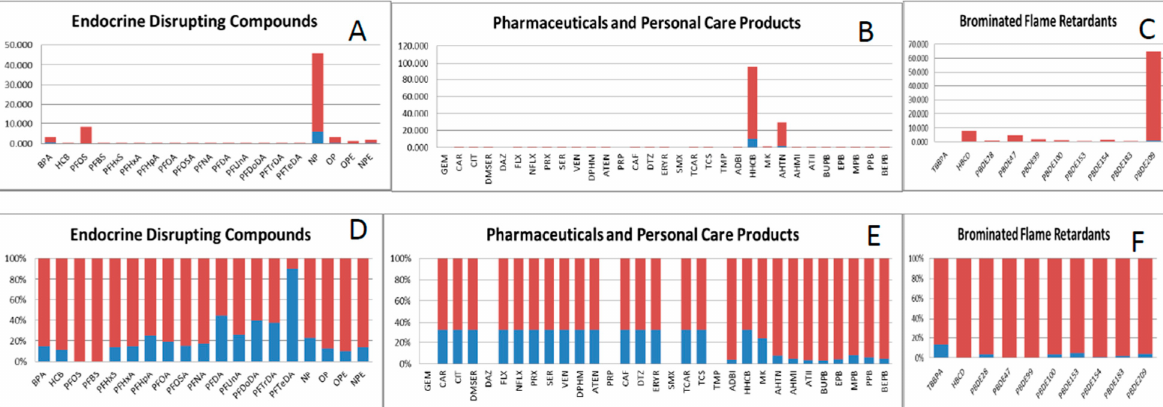
Figure 3. Integrated risk index of different group of compound showing ( A – C ) the ratio of mean (50 percentile) and max (99 percentile) IRI score and ( D – F ) the percentage of mean (50 percentile) and max (99 percentile) score.